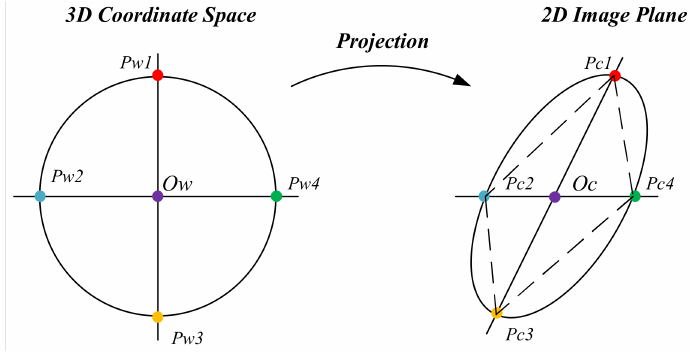
Figure 9. Projection of circular target.